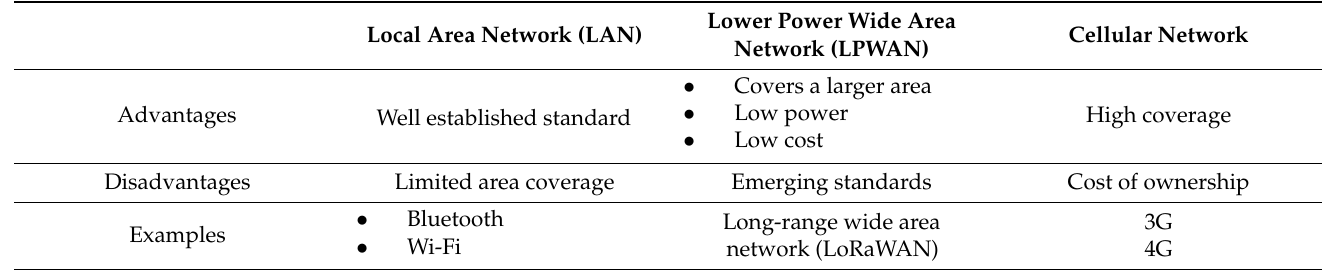
Table 2. A comparison of different technologies on data transmission for tree monitoring.